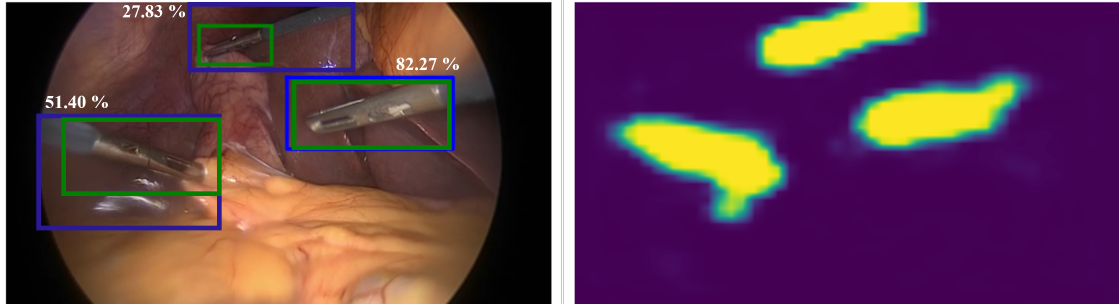
Figure 7. Multiple instances of the grasper ( left ) and the localization map ( right ). The green and blue boxes represent the manually labeled and predicted bounding boxes, respectively. Each bounding box is labeled by the IoU (%) value.